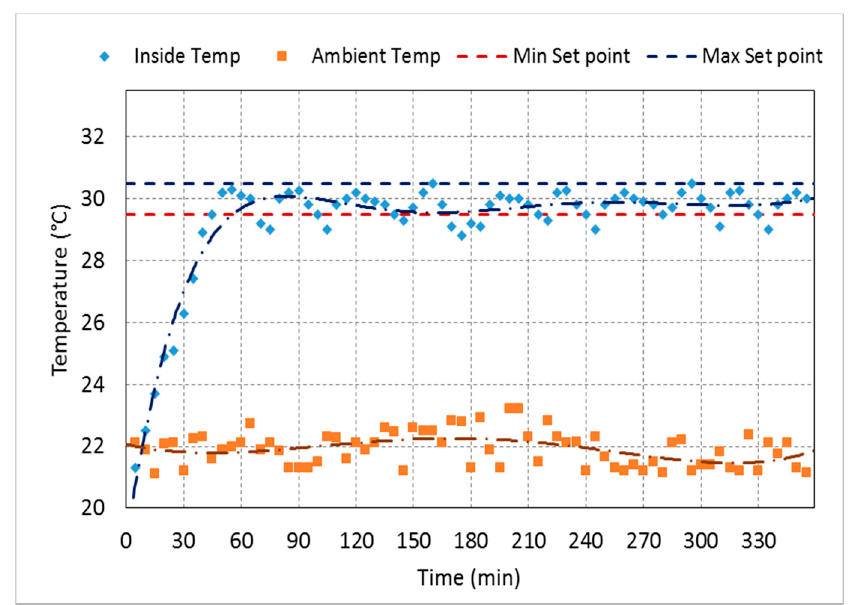
Figure 15. Ambient temperature, inside temperature of the testing chamber, compared to the minimum and maximum set points of 29.5 °C and 30.5 °C to obtain the target temperature of 30 °C at 35% relative humidity (RH) for 6 h.